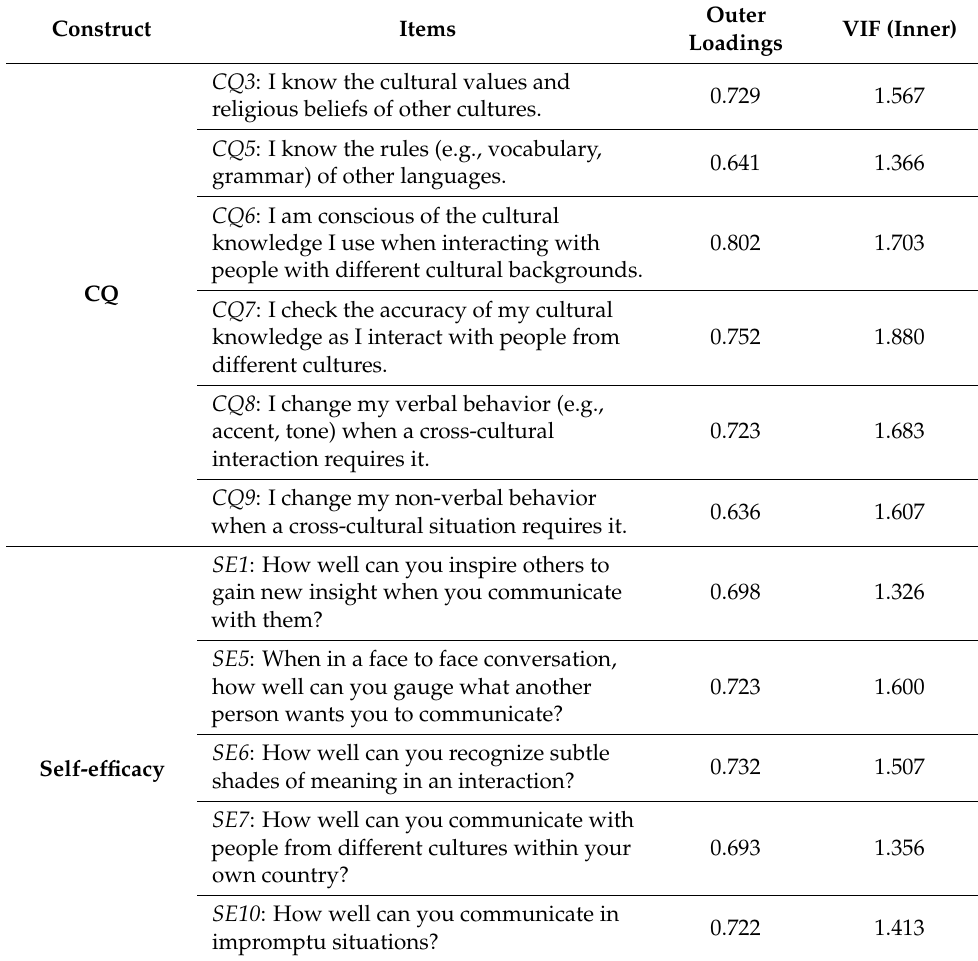
Table 3. Measurement model and VIF (multicollinearity). Source: own